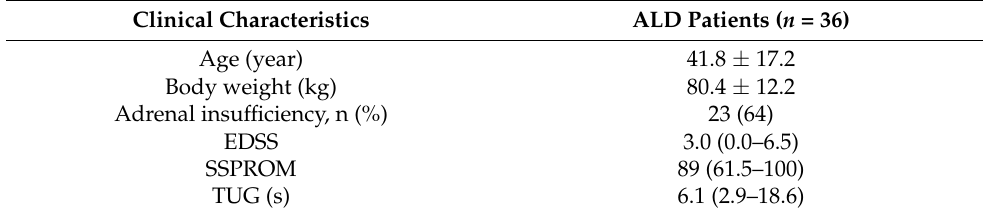
Table 2. Clinical characteristics of ALD patients.